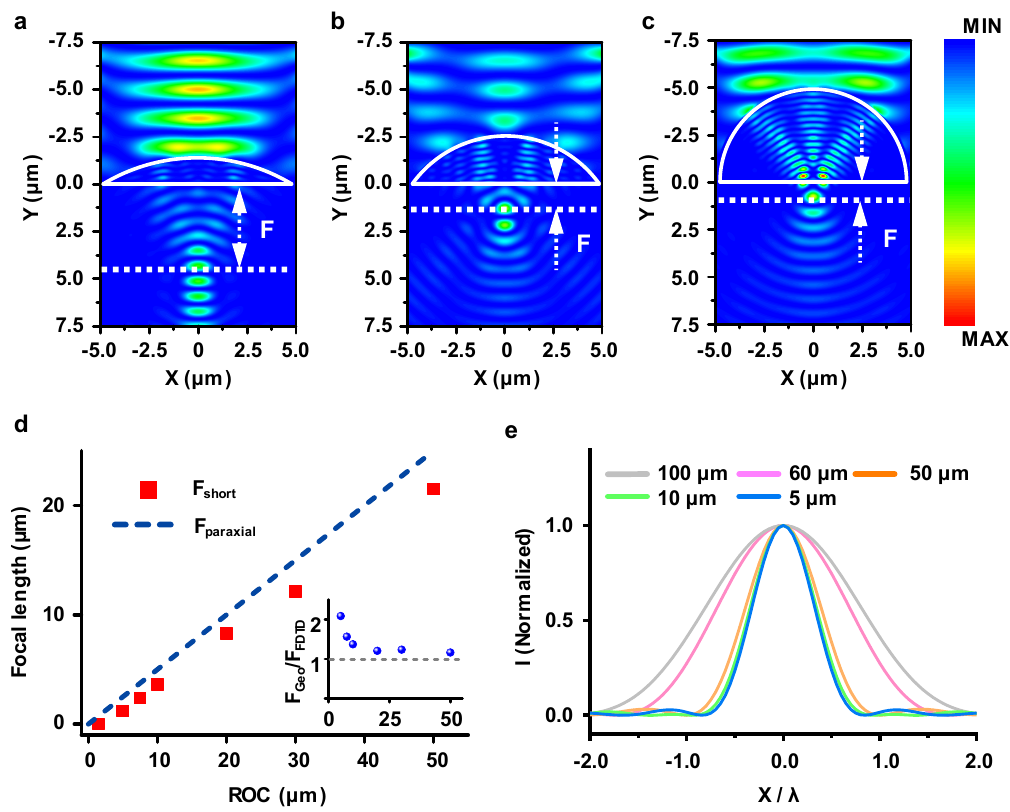
Figure 2. E-field intensity distribution of plane wave illumination onto a µ -SIL showing the variation of focal length for µ -SILs with radius to height ratios of ( a ) 3:1, ( b ) 2:1, and ( c ) 1:1 (hemispherical geometry). The refractive index used in this simulation was set as n = 3.5 (silicon). ( d ) Plot of focal length vs. µ -SIL radii of curvature (RoC). The line represents the calculated focal length using F paraxial = RoC / ( n -1) and red markers are the results from the finite-di ff erence time-domain (FDTD) simulation. The inset shows the ratio of geometrical focal length and those obtained by full width at half maximum (FWHM) simulation, respectively. ( e ) E-field intensity distribution on the focal region representing the variation of FWHM depending on the µ-SIL RoCs.